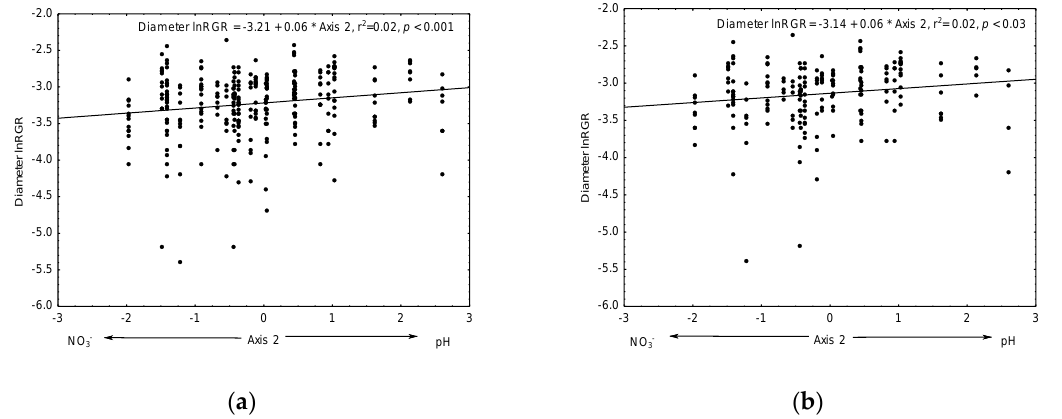
Figure 7. Regression of diameter lnRGR for (a) all tree species and (b) for fast-growing species as a function of PCA scores with soil properties in 2014. Value of r 2 , regression line, and equation are shown.